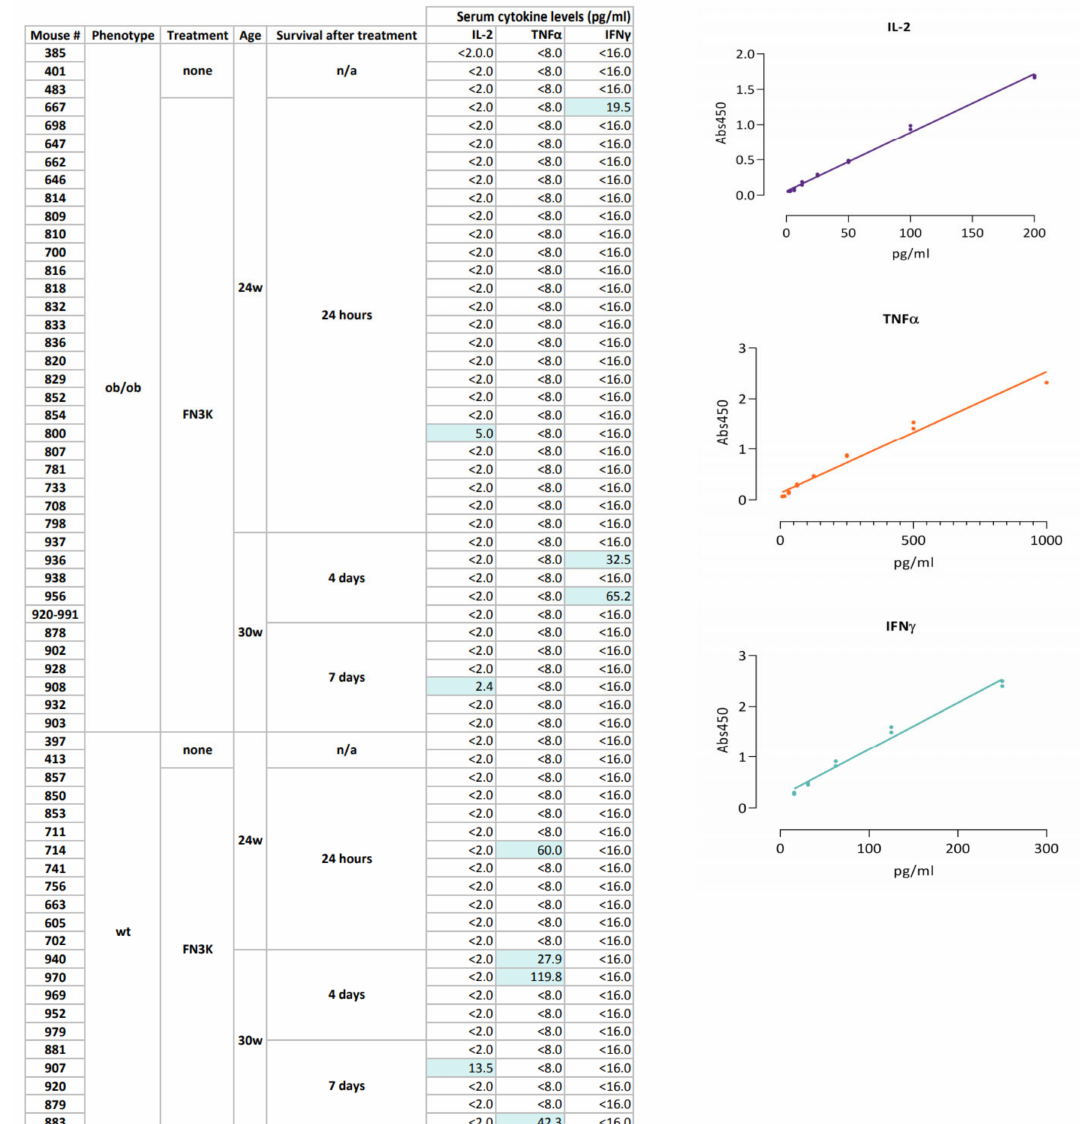
Figure A1. Serum ELISA results of IL-2, TNF α and IFN γ in non-treated ob/ob and WT mice ( n = 5) and FN3K-treated mice ( n = 55). In all non-treated mice serum levels of IL-2, TNF α and IFN γ were below detection limits (2 pg/mL, 8 pg/mL and 16 pg/mL, respectively). In a large majority of FN3K-treated mice (45 out of 55), levels of these 3 cytokines were below detection limits as well. In several serum samples (10 out of 55), one of the three cytokines tested for was upregulated. However, cytokine levels were not consistently high within treatment groups and in general were very low (below 120 pg/mL). From this, we could conclude that intravitreal injection of a therapeutic FN3K mixture did not consistently provoke a systemic immune response. Calibration curves of IL-2, TNF α and IFN γ are illustrated on the right